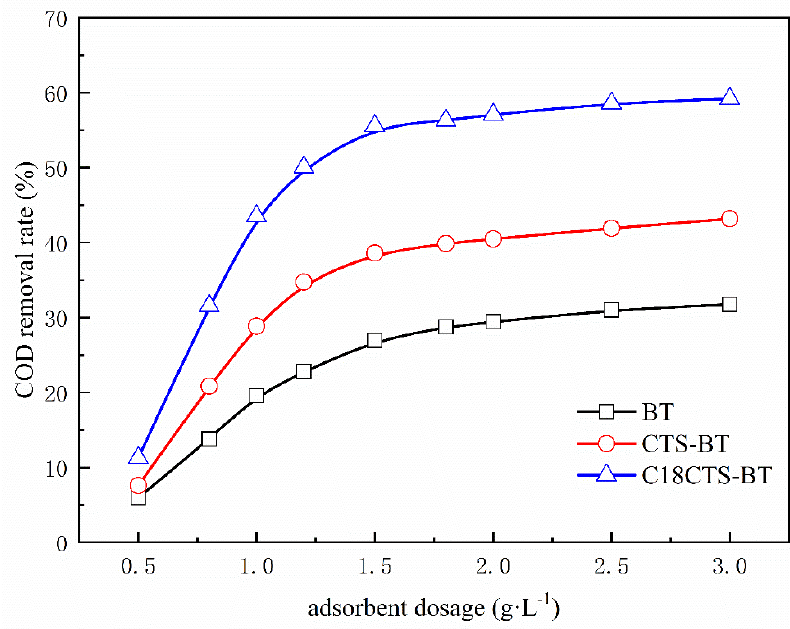
Figure 6. Effect of adsorbent dosage on removal rate of COD (pH = 7.0; adsorption time is 2 h).